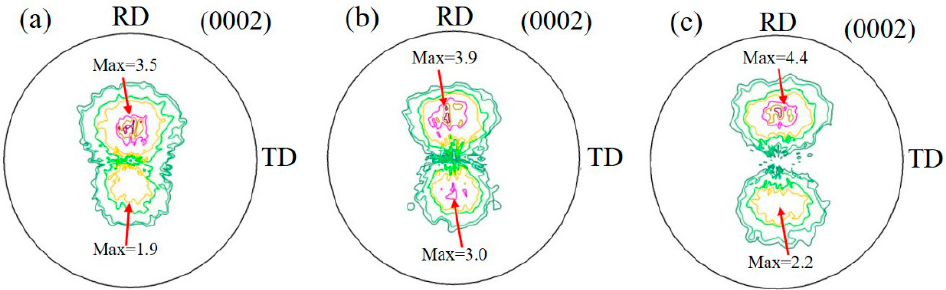
Figure 8. Pole figures (0002) of the ECAR-CB-A AZ31 Mg alloy samples prepared at different final rolling temperatures: ( a ) 350 °C, ( b ) 450 °C and ( c ) 550 °C.